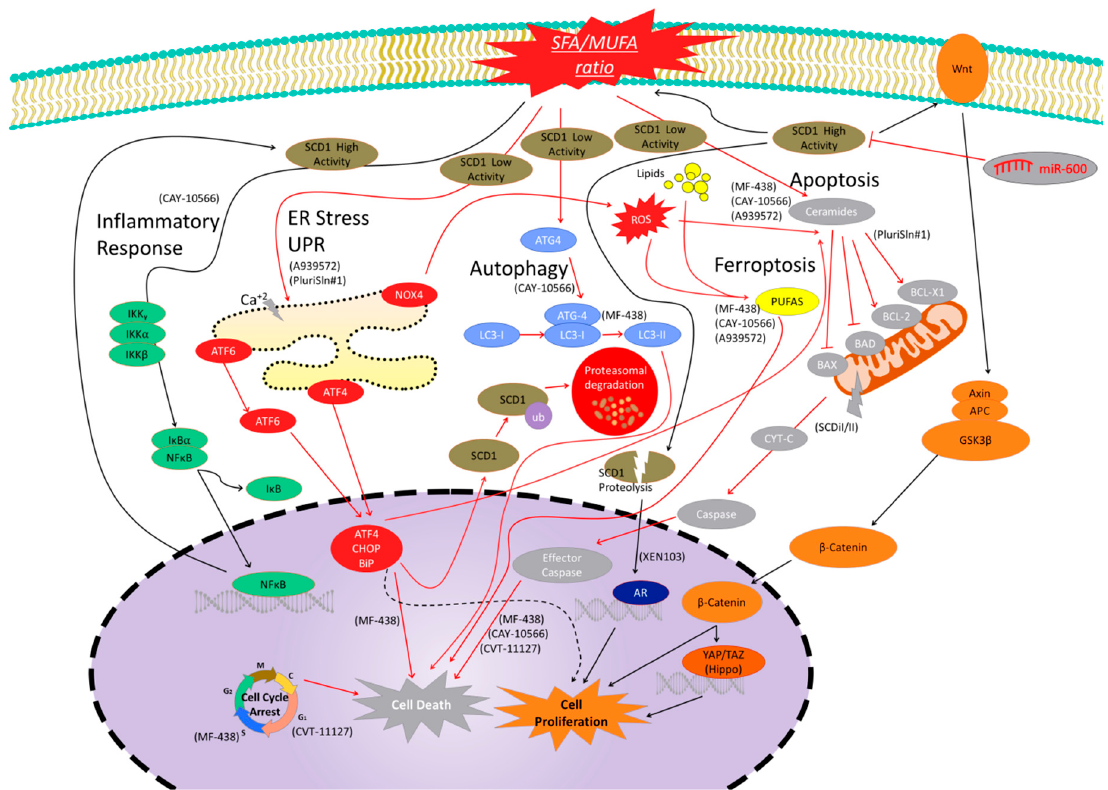
Figure 2. Signaling pathways modulated by SCD1 activity and levels. Black arrows are signals of cell proliferation or associated with high SCD1 expression or activity, while red arrows are signals linked to cell death or decreased SCD1 expression or activity. Inflammatory pathway is shown in green. SCD1 inhibition reduces the pro-inflammatory environment and nuclear factor kappa-B (NF κ B) signaling to reduce cell proliferation, while NF κ B signaling activation promotes transcription factors binding to SCD1 promotor and gene expression. The Wnt/ β -catenin pathway is related to cell proliferation and it is shown in orange. High SCD1 levels are linked to increased β -catenin signaling and increased levels of wingless-related integration site (Wnt) ligands to induce cell proliferation. Hippo pathway is a β -catenin-related signal cascade, which is associated with cell proliferation, and SCD1 inhibition has been demonstrated to be associated with decreased levels of Hippo target genes. This pathway is shown in dark orange. The SCD1 peptides from proteolytic controlled degradation activate androgen receptor (AR) signaling to promote cell proliferation. This pathway is shown in dark blue. The autophagy cell death pathway is a protein cascade which is upregulated after SCD1 inhibition. Some central elements of this pathway are shown in light blue. The endoplasmic reticulum (ER) stress signal pathway is shown in red. This cascade is linked to misfolded and unfolded proteins to induced cell death. SCD1 inhibition has been linked to the upregulation of the elements of the ER pathway to promote cell death. SCD1 is also ubiquitinated by this pathway to promote protein degradation. However, light ER pathway activation has also been related to cell survival (dashed black arrows). Apoptosis is a programmed cell death shown in grey that is activated after SCD1 inhibitor treatments. Increased ceramides, mitochondrial effector pathway, caspases, and other pathway effectors have been detected after treatments. Ferroptosis is another cell death mechanism (yellow) that has been shown to be activated after SCD1 Inhibition. Finally, SCD1 inhibition has been demonstrated to induce cell cycle arrest in different checkpoints to promote cell death. Molecules in parentheses are SCD1 inhibitors used in the literature to elucidate the SCD1-related pathways.